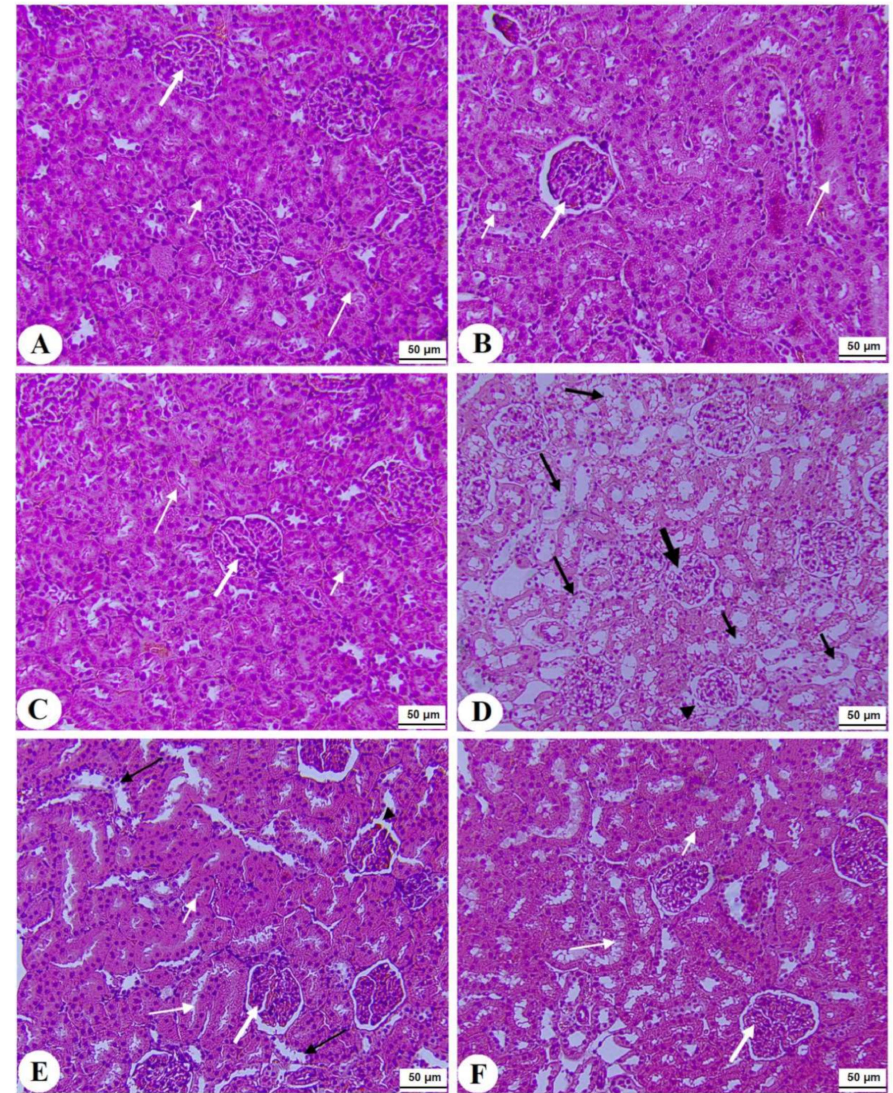
Figure 7. Histological section of the kidneys of all groups of rats ( A – C ): Histological section taken from control, Fenugreek seed aqueous extract (FS-AE), and Fenugreek seeds galactomannan (F-GAL)- treated rats and showing normal kidney morphology with intact glomerulus and glomerular mem- branes (long thick white arrow), proximal convolutes tubules (PCTs) (short white arrow), and distal convoluted tubules (DCTs) (long thin white arrow). ( D ): Section taken from a streptozotocin (STZ) di- abetic rat and showing a reduced glomerular mass (long thick black arrow) and damaged glomerular membrane (arrowhead), PCTs (short, thin black arrow), and DCTs (long thin black arrow). ( E , F ): Sec- tions taken from STZ + FS-AE and STZ + F-GAL-treated rats, respectively, and showing almost normal features, similar to those in the control rats. However, some damage in the DCTs was still seen in STZ + FS-AE-treated rats (thin black arrow). This section may be divided into subheadings.